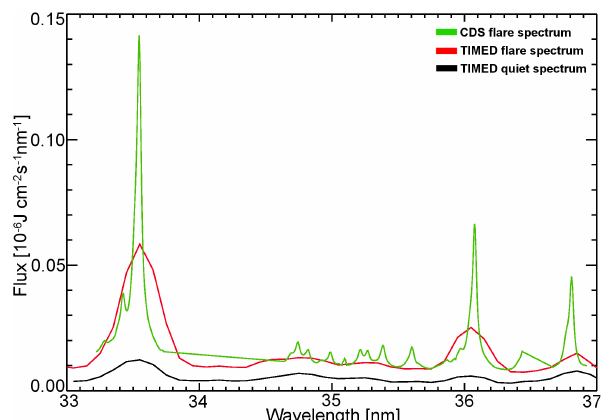
Fig. 4. Comparison of the EUV spectra of the X17.2 flare represent- ing the 2.3Gyr old Sun and the younger 0.65Gyr old solar proxy κ 1 Cet that shows higher emission than the flare